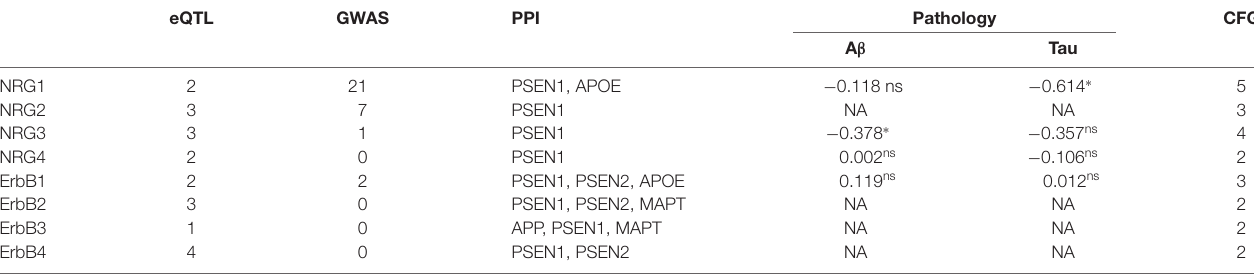
TABLE 3 | Convergent functional genomic (CFG) ranking for NRGs and their ErbB receptors in AD (Xu et al., 2018; Zhang et al., 2019). eQTL GWAS PPI Pathology CFG A β